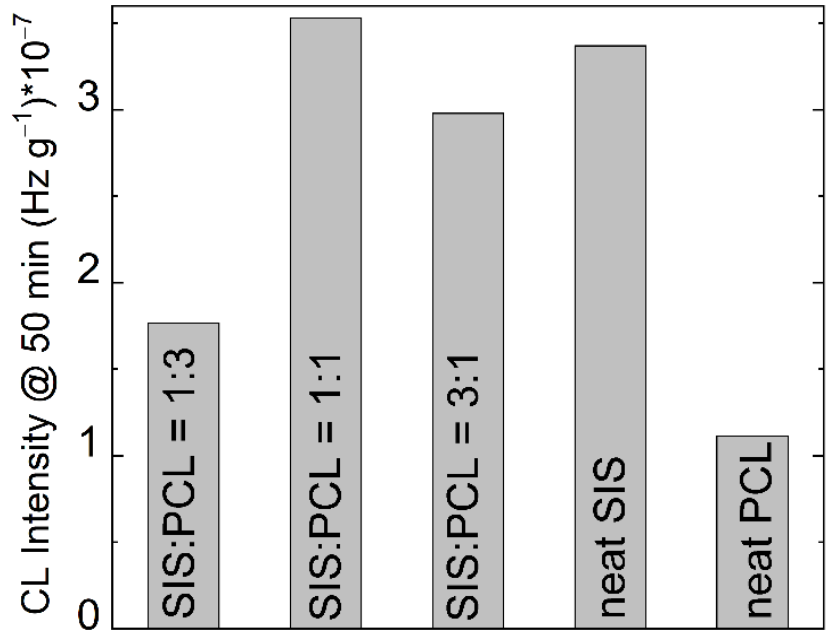
Figure 5. Histogram on the oxidation stages for PCL/SIS mixtures irradiated at 25 kGy.